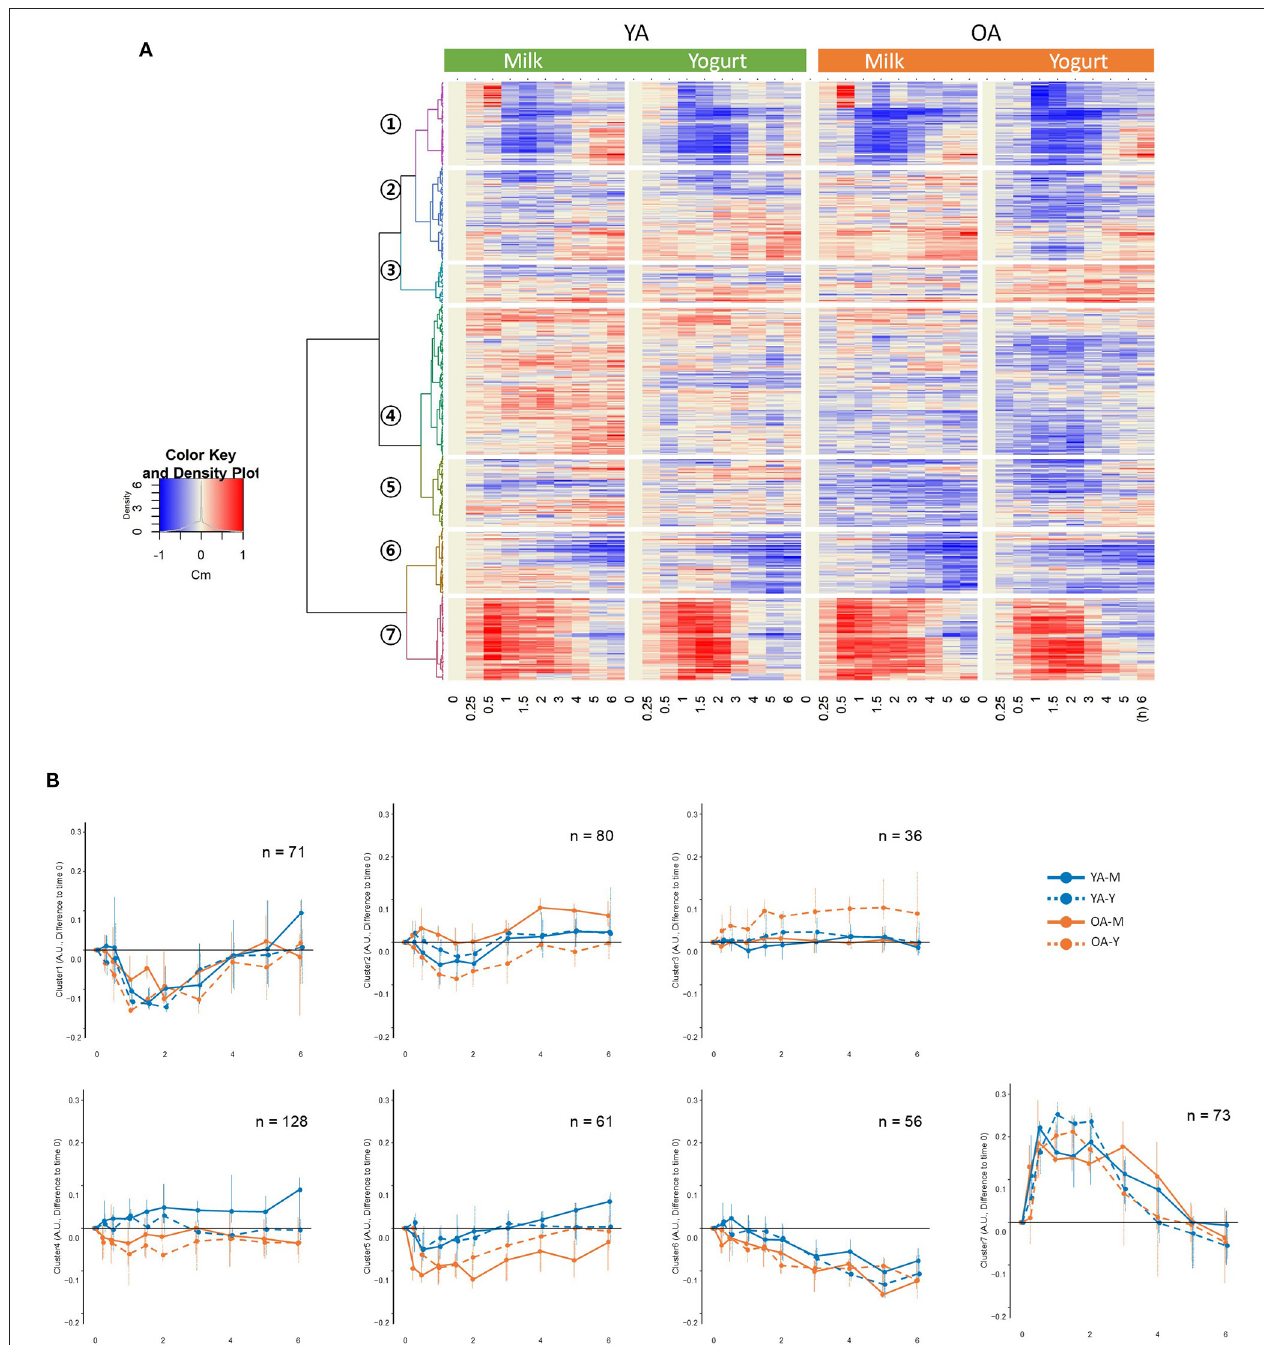
FIGURE 3 | (A) Hierarchical clustering analyses on the 505 metabolic features showing significant responses during the postprandial phase. (B) postprandial representation of the mean values for the metabolic features belonging to the seven identified clusters. YA-M, young adults-milk intake; YA-Y, young adults-yogurt intake; OA-M, older adults-milk intake; OA-Y, older adults-yogurt